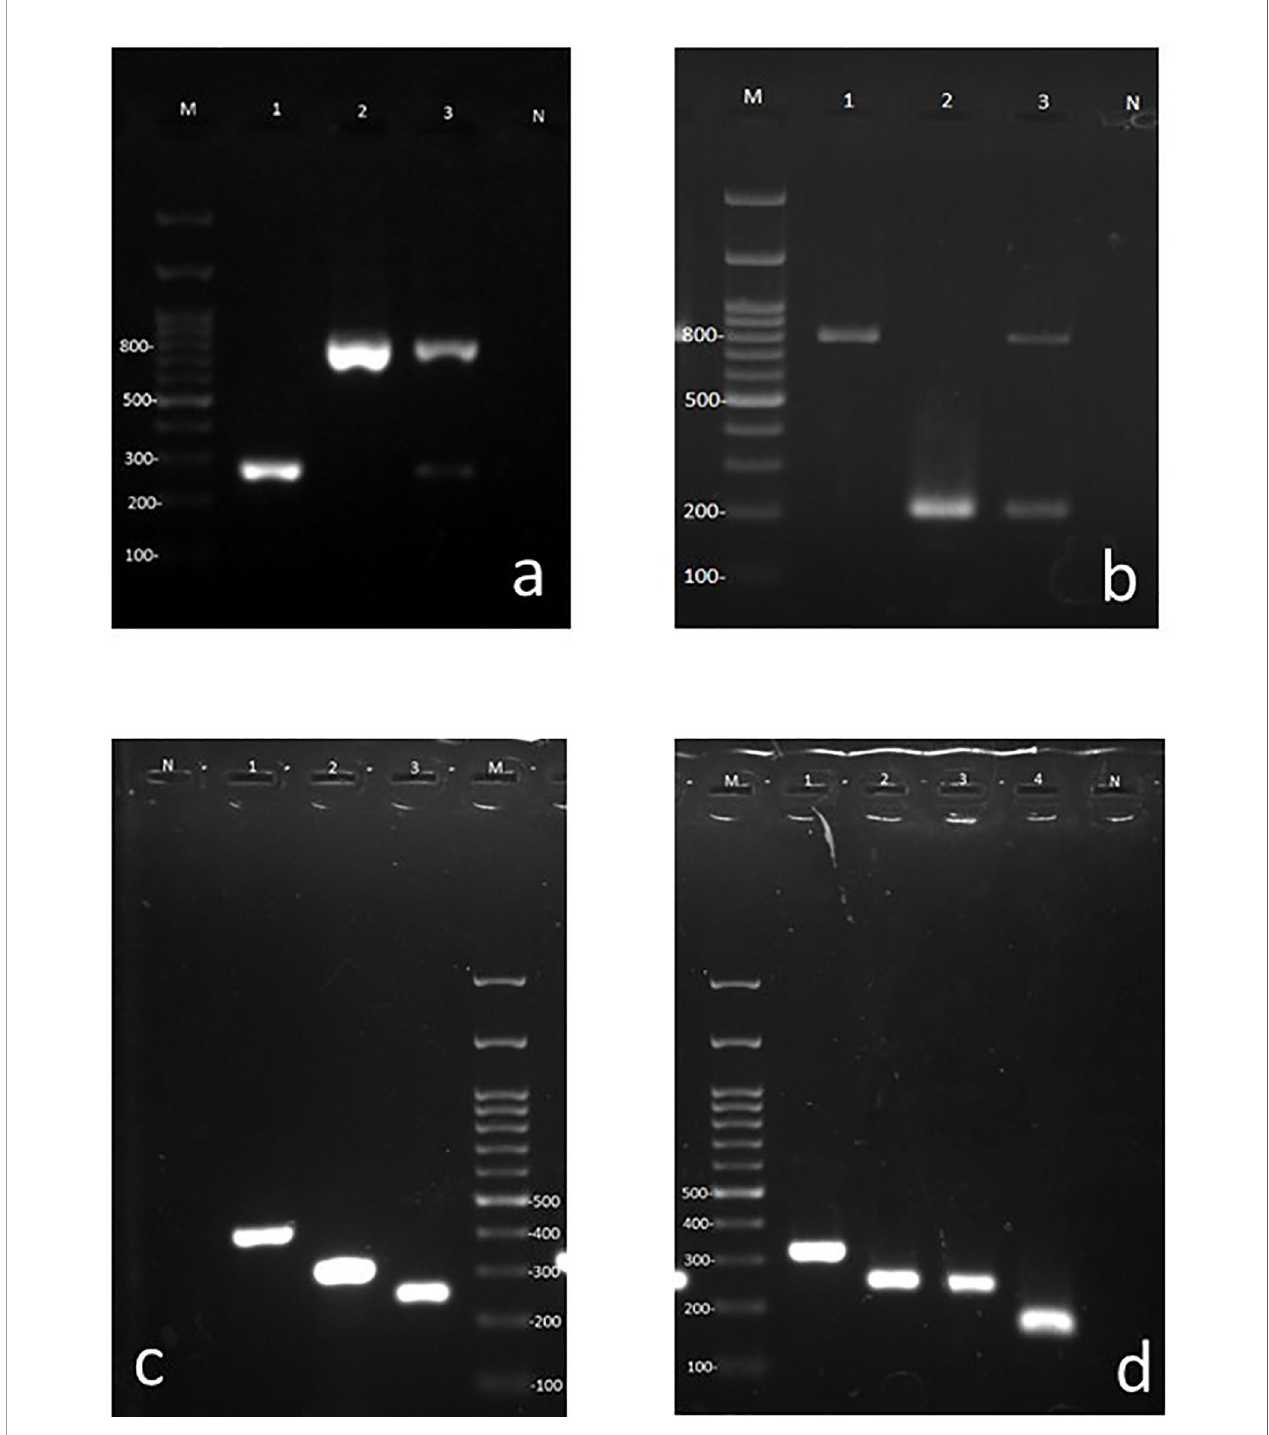
FIGURE 2 | Agarose gels containing representative amplicons. (A) First step multiplex PCR using universal bacterial and fungal primers. Lane M 100 bp ladder, Lane 1: Bacterial (265 – 267 bp band), Lane 2: Fungal (783 – 800 bp band), Lane 3: Fungal and bacterial co-infection (dual bands of 265 – 267 and 783 – 800 bps), Lane N: negative control for PCR. (B) Pseudomonas and Staphylococcus speci fi c primer pairs (bacterial duplex PCR), Lane M: 100 bp ladder, Lane 1: Staphylococcus , Lanes 2: Pseudomonas , 3: mixed of Pseudomonas and Staphylococcus (dual bands of 198 and 756 bp, respectively), Lane N: negative control for PCR. (C) Candida species speci fi c multiplex primers. Lane N: negative control for PCR, Lane1: C. albicans , Lane 2: C . parapsilosis , Lane 3: C . auris , Lane M: 100 bp ladder. (D) Aspergillus species speci fi c multiplex primer. Lane M: 100 bp ladder, Lane 1: A . terreus , Lane 2: A . tubingensis , Lane 3: A . niger , Lane 4: A . fl avi , Lane N: negative control for